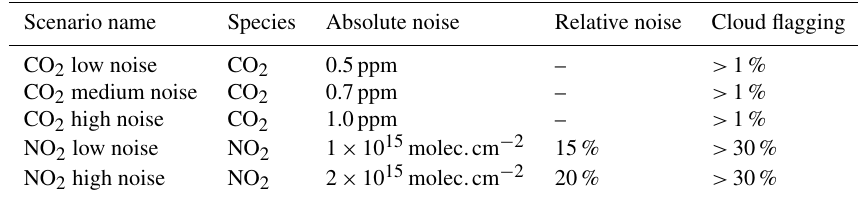
Table 1. Uncertainty scenarios and cloud flagging threshold for the instruments on board the CO2M satellites. For the NO 2 measurements, either absolute or relative noise is used depending on which is